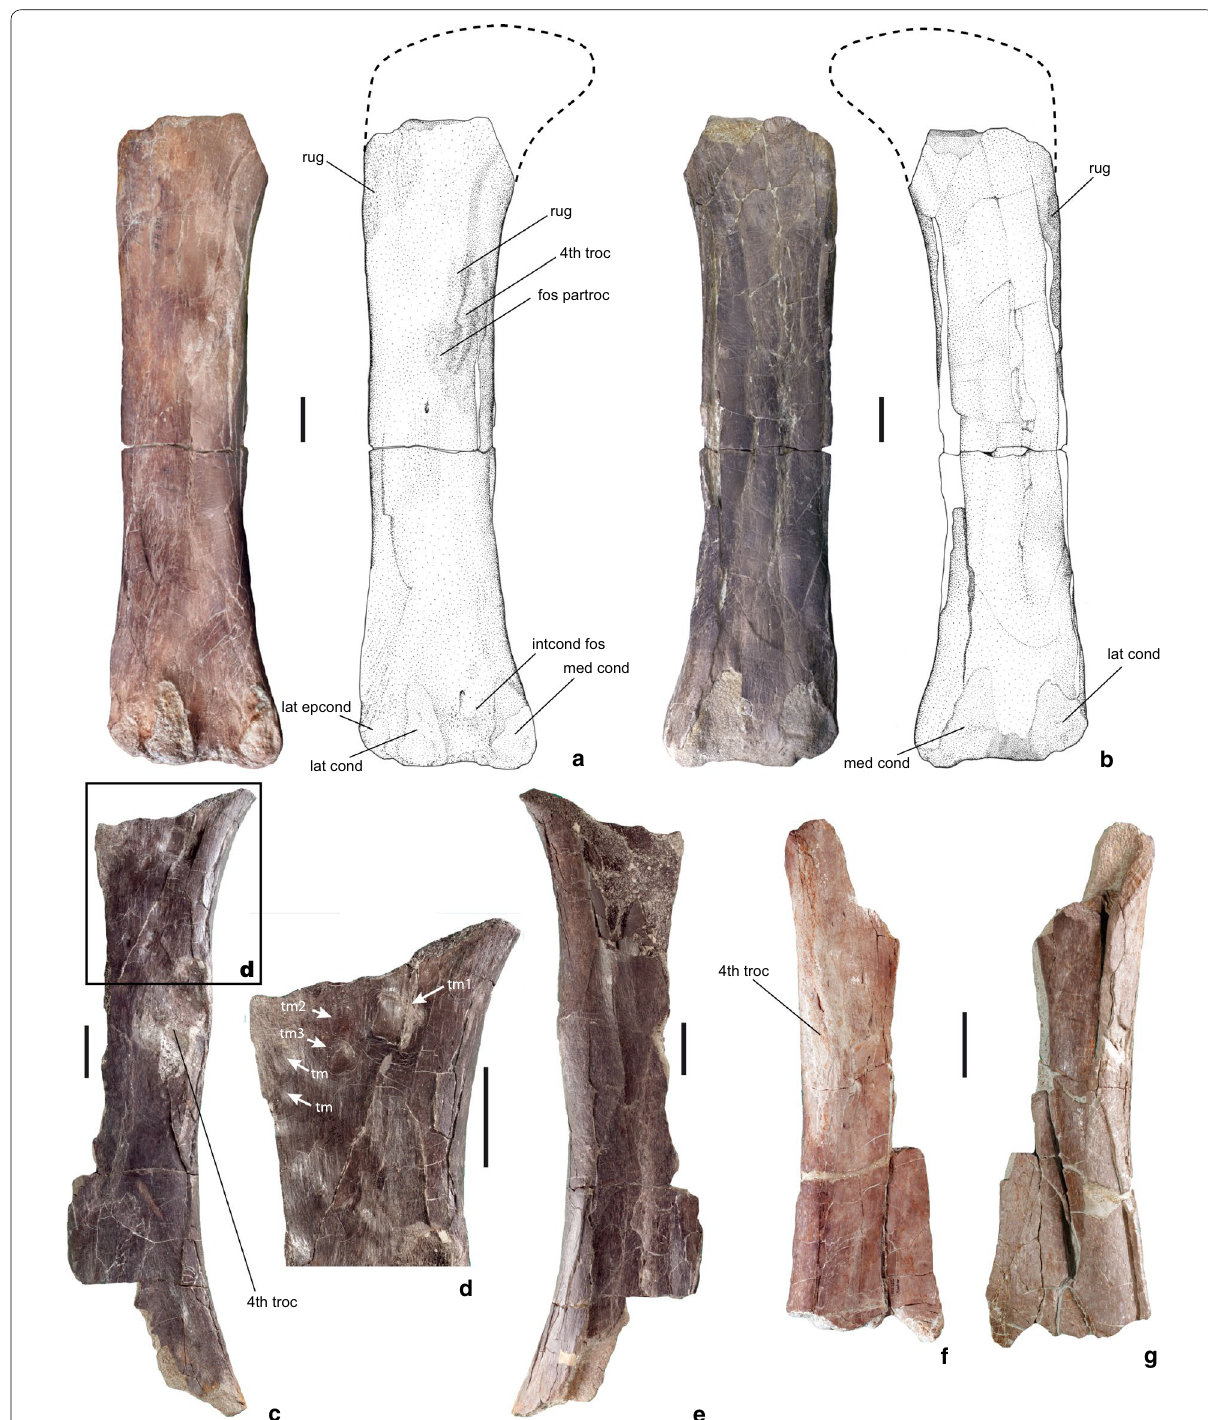
Fig. 12 Femora of A . greppini . Left femur NMB M.H. 372, photograph and interpretative drawing in a posterior and b anterior aspect, hatched line shows reconstructed supposed outline of femoral head. Left femur NMB M.H. 349 in c posterior aspect with box indicating d enlarged detail of posterior face of proximal femur with bite marks, some of them indicated by white arrows, e anterior aspect. Right femur NMB M.H. 262 in f posterior and g anterior aspect. Scale bar is 50 mm. Drawings by Serafin Padzera. fos partroc fossa paratrochanterica, intcond fos intercondylar fossa, lat cond lateral condyle, lat epcond lateral epicondyle of femur, med cond medial condyle, rug rugosity, tm tooth mark, 4th troc fourth trochanter of